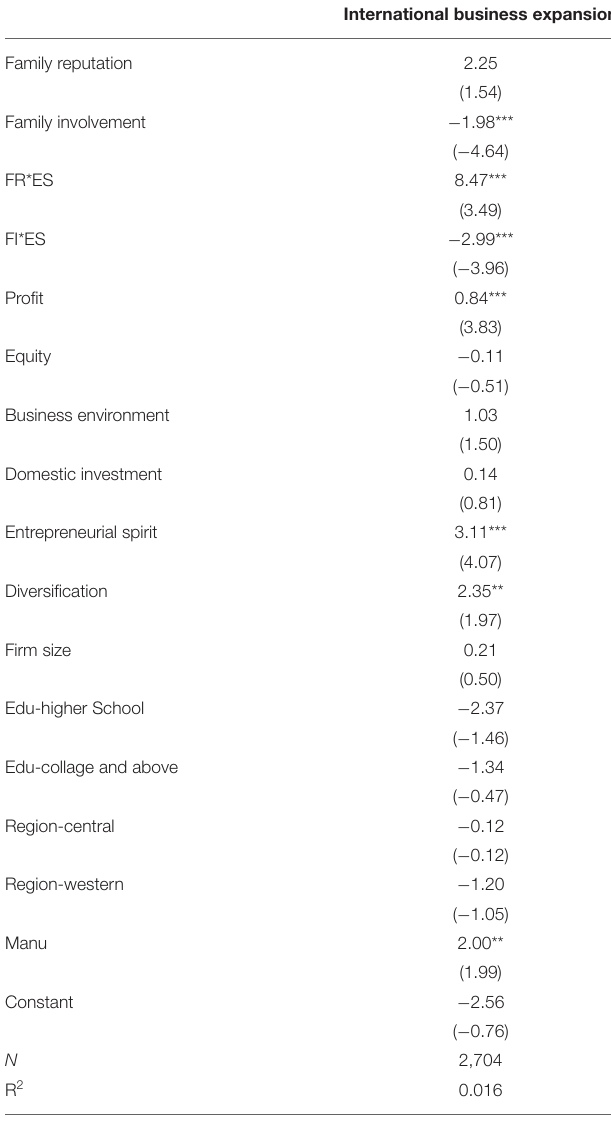
TABLE 5 | The results of tobit